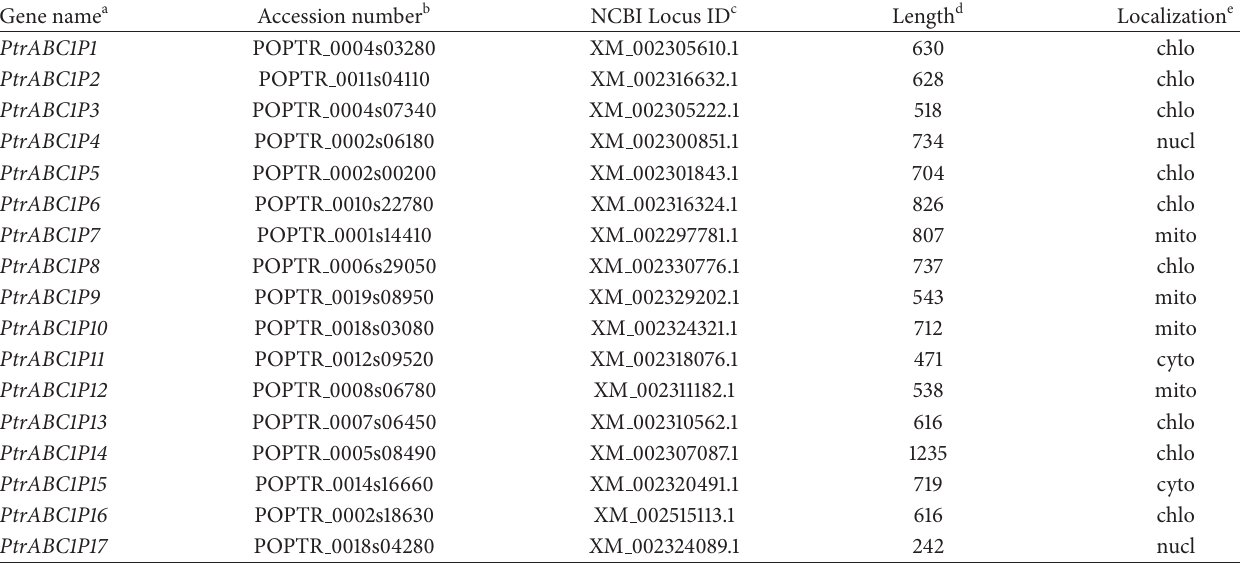
Table 1: ABC1 gene family in P. trichocarpa .